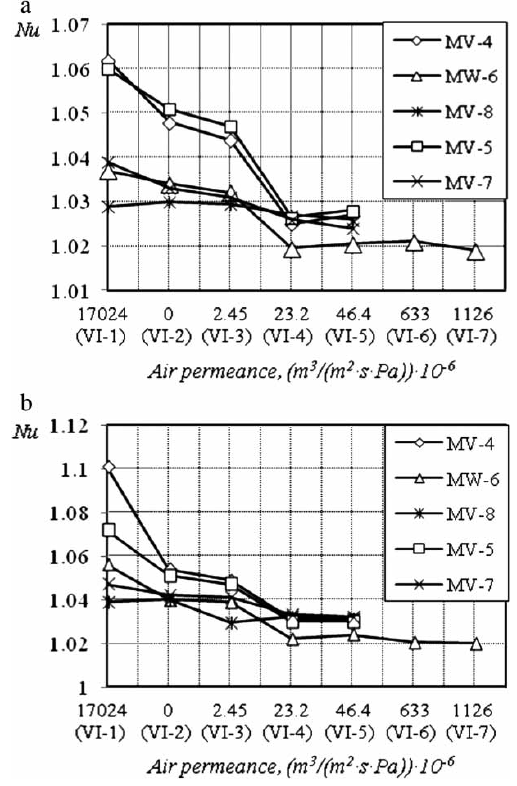
Fig. 11. The dependence of the Nusselt criterion of thermal- insulating layer ( d (cid:2) 150 mm) on the air permeance of wind protection and its type when heat transfer is affected exclusively by natural convection (a) by both natural and forced convection ( grad P (cid:2) 3.0 Pa) (b). The measurements carried out under environmental temperatures u i (cid:2)(cid:4) 20 8 C and u e (cid:2) (cid:5) 10 8